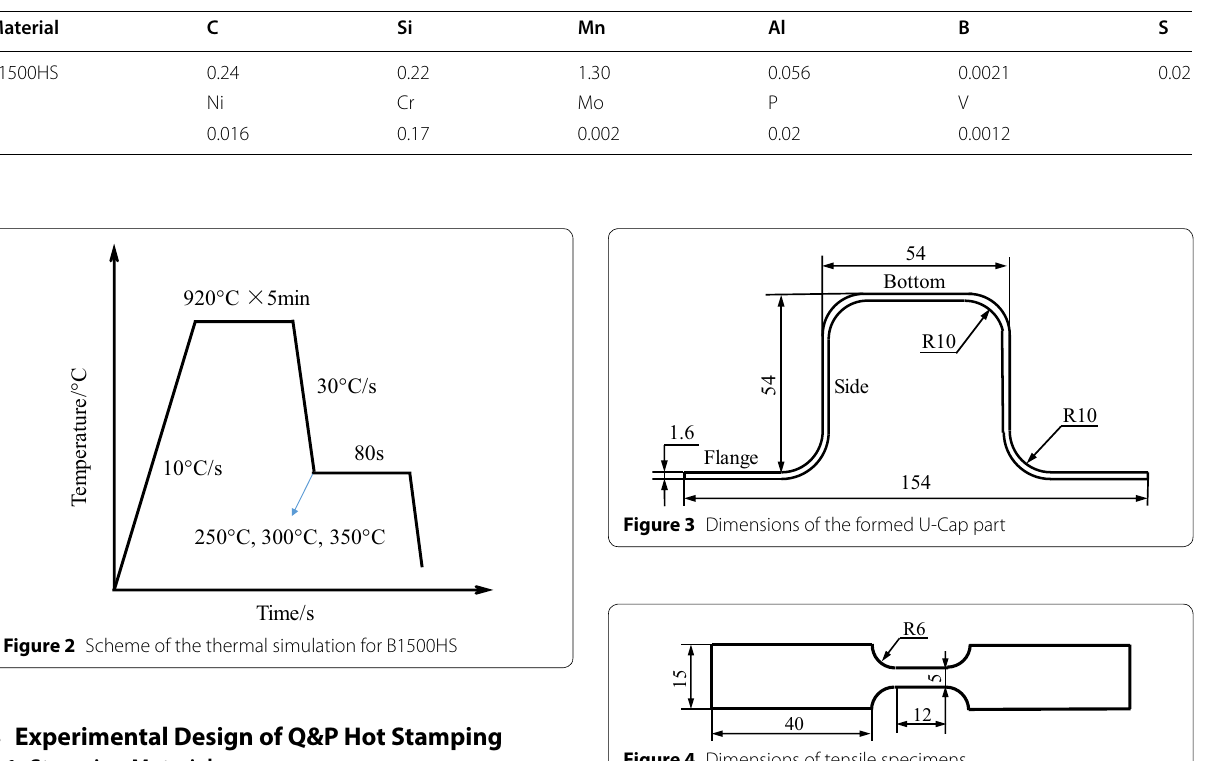
Figure 4 Dimensions of tensile